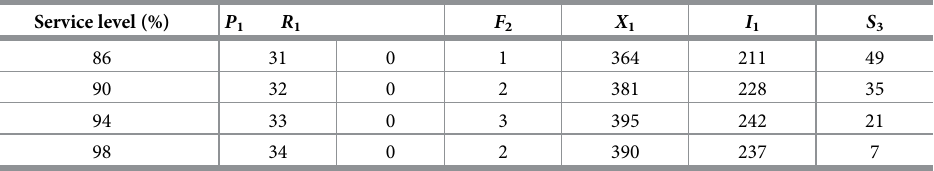
Table 13. Impact of the service level constraint respect to decision variables in Model-II. Own elaboration. Service level (%) P 1 R 1 F